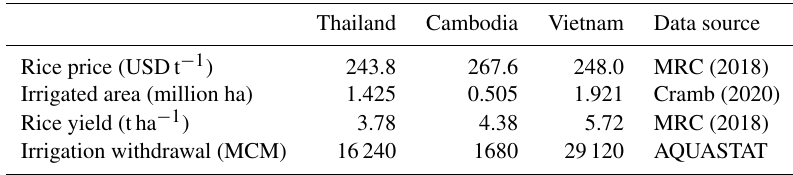
Table 2. Irrigated agriculture information of Thailand, Cambodia and